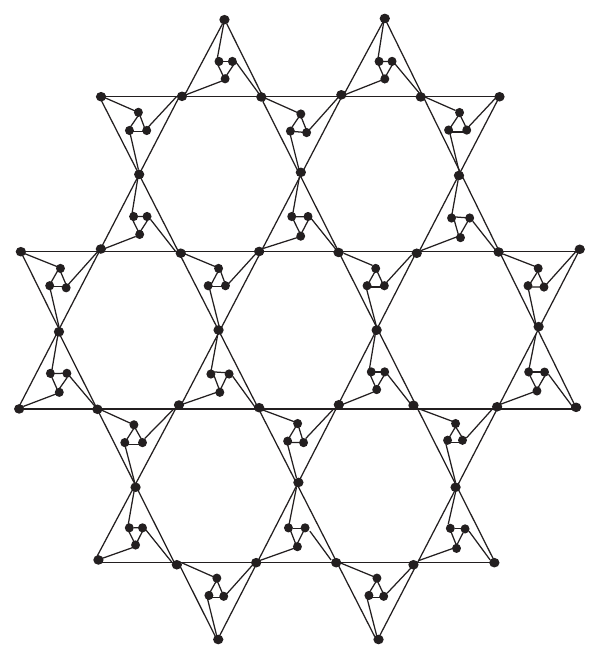
Figure 2: Triangular prism network TP ( 2 ) .